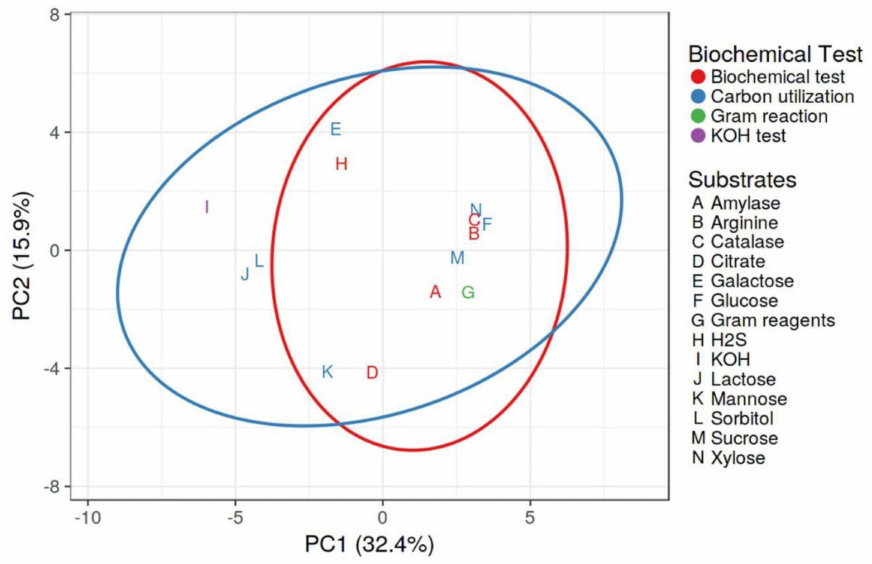
Figure 5. Principal component analysis depicting correlation and significance between biochemical tests and substrate utilization profiling of rhizobacterial